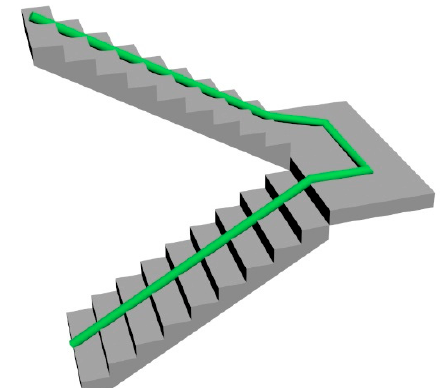
Figure 14. Travel path on stairs (green line).